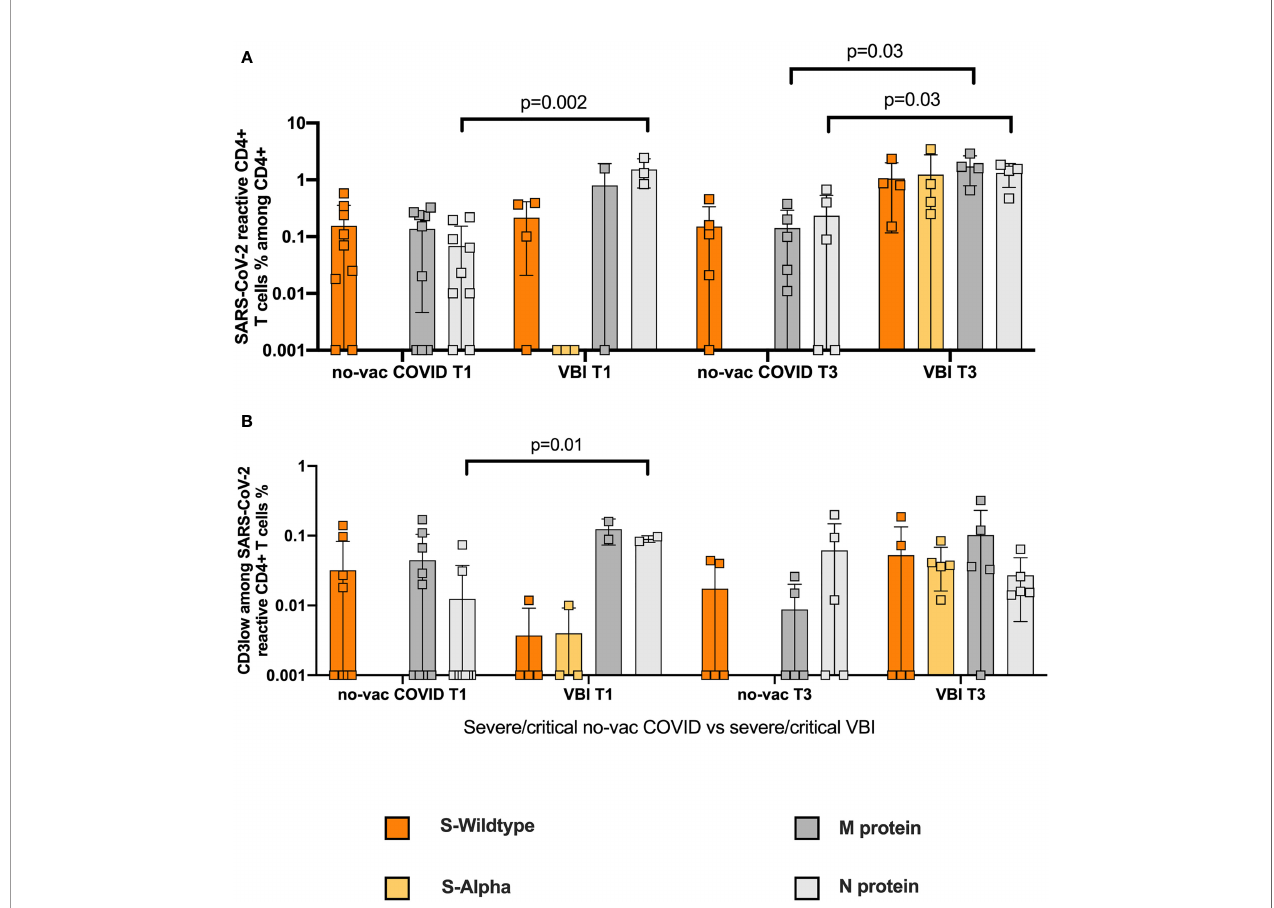
FIGURE 4 | No vaccination advantage in VBI group compared to no-vac COVID group with severe and critical disease. Comparison of SARS-CoV-2 reactive CD4+ T cell response among the severe and critical VBI patients versus the severe and critical no-vac COVID-19 patients. (A) Frequencies of WT S- and M-reactive CD4+ T cells at T1 and T3 for the two cohorts are depicted (B) Comparison of CD3low populations of the unvaccinated COVID-19 cohort compared to the VBI